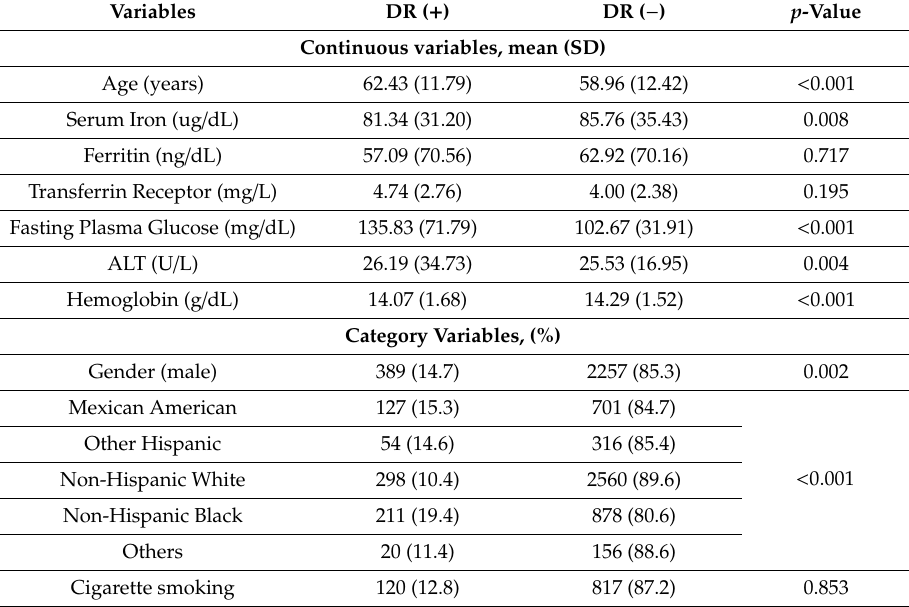
Table 2. Demographic information of study